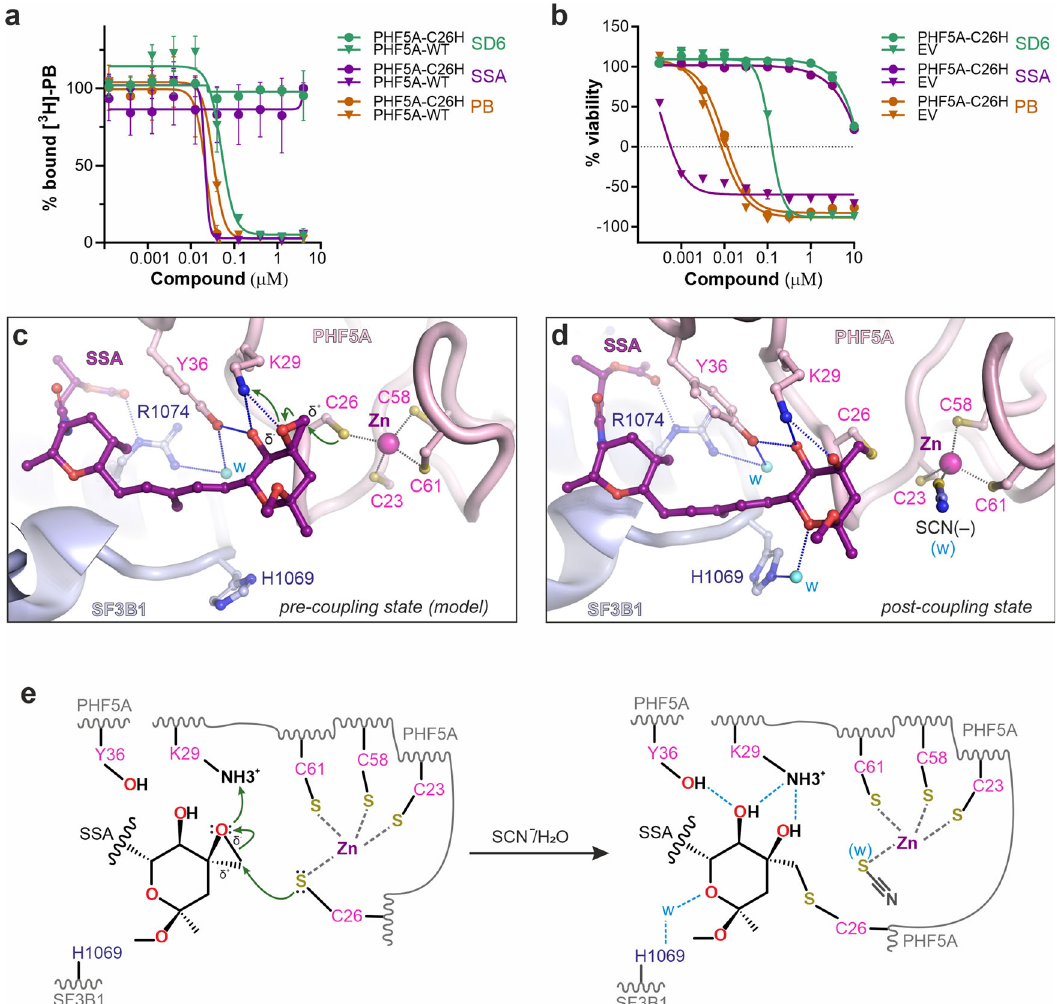
Fig. 4 Mechanism of covalent coupling to the nucleophilic zinc fi nger. a Competitive titration of [ 3 H]-pladienolide B (10 nM) with SSA, SD6, and PB by scintillation proximity assays (SPA). Error bar indicates SEM, n = 2 biological replicates. Source data are provided in the Source Data fi le. b Cell growth inhibition assays of HCT116 cells harboring the C26H-PHF5A point mutation. Control cells were transfected with an empty vector. Error bar indicates SEM, n = 2 biological replicates. Source data are provided in the Source Data fi le. c Model for the pre-coupling state was obtained by docking the unreacted ligand into the experimental density of the covalently-linked SSA. d Crystal structure of SF3B Δ BPB -SSA corresponding to the post-coupling state depicted as in c for a side-by-side comparison. e Mechanism of covalent coupling of epoxy modulators to the nucleophilic zinc fi nger of PHF5A, as inferred from crystal structures and stereochemistry. Available structural data and functional assays favor a nucleophilic substitution mechanism where the activated thiolate group of C26 carries the nucleophilic attack, whereas K29 stabilizes the leaving hydroxyl group. The zinc-bound C26 can be replaced either by water or